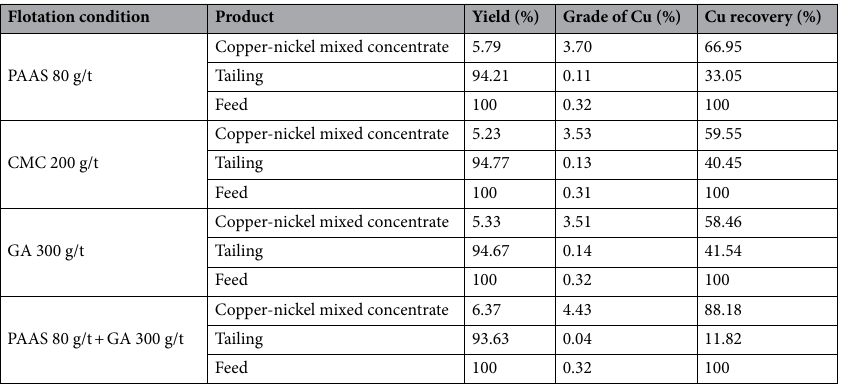
Table 7. Results of copper sulphide beneficiation at pH = 9.2.